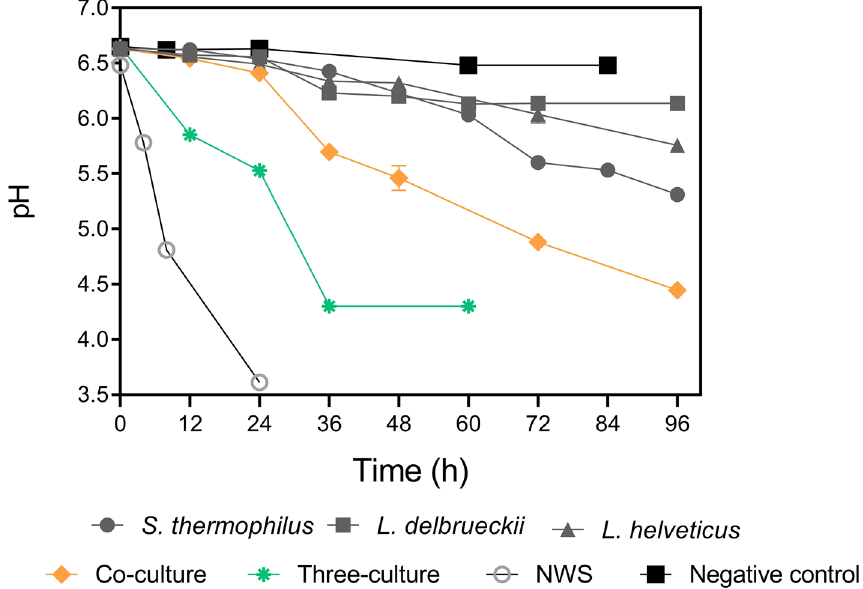
Figure 8. Acidification curves of St. thermophilus , L. helveticus and L. delbrueckii susp. lactis axenic cultures isolated from NWS. Tester strains were inoculated in milk as monocultures (grey), coculture ( St. thermophilus RBC06 x. L. delbrueckii susp lactis CBB09) (orange), and triculture ( St. thermophilus RBC06 x. L. delbrueckii susp lactis CBB09 × L. helveticus RBB04) (green). Milk inoculated with fresh NWS (light grey) and uninoculated milk (black) were used as positive and negative controls, respectively. Values are mean of at least three replicates. Bars when visible represent standard deviation values. Plotted with GraphPad Prism v.8.00 software (San Diego, CA, USA, https:// www. graph pad.